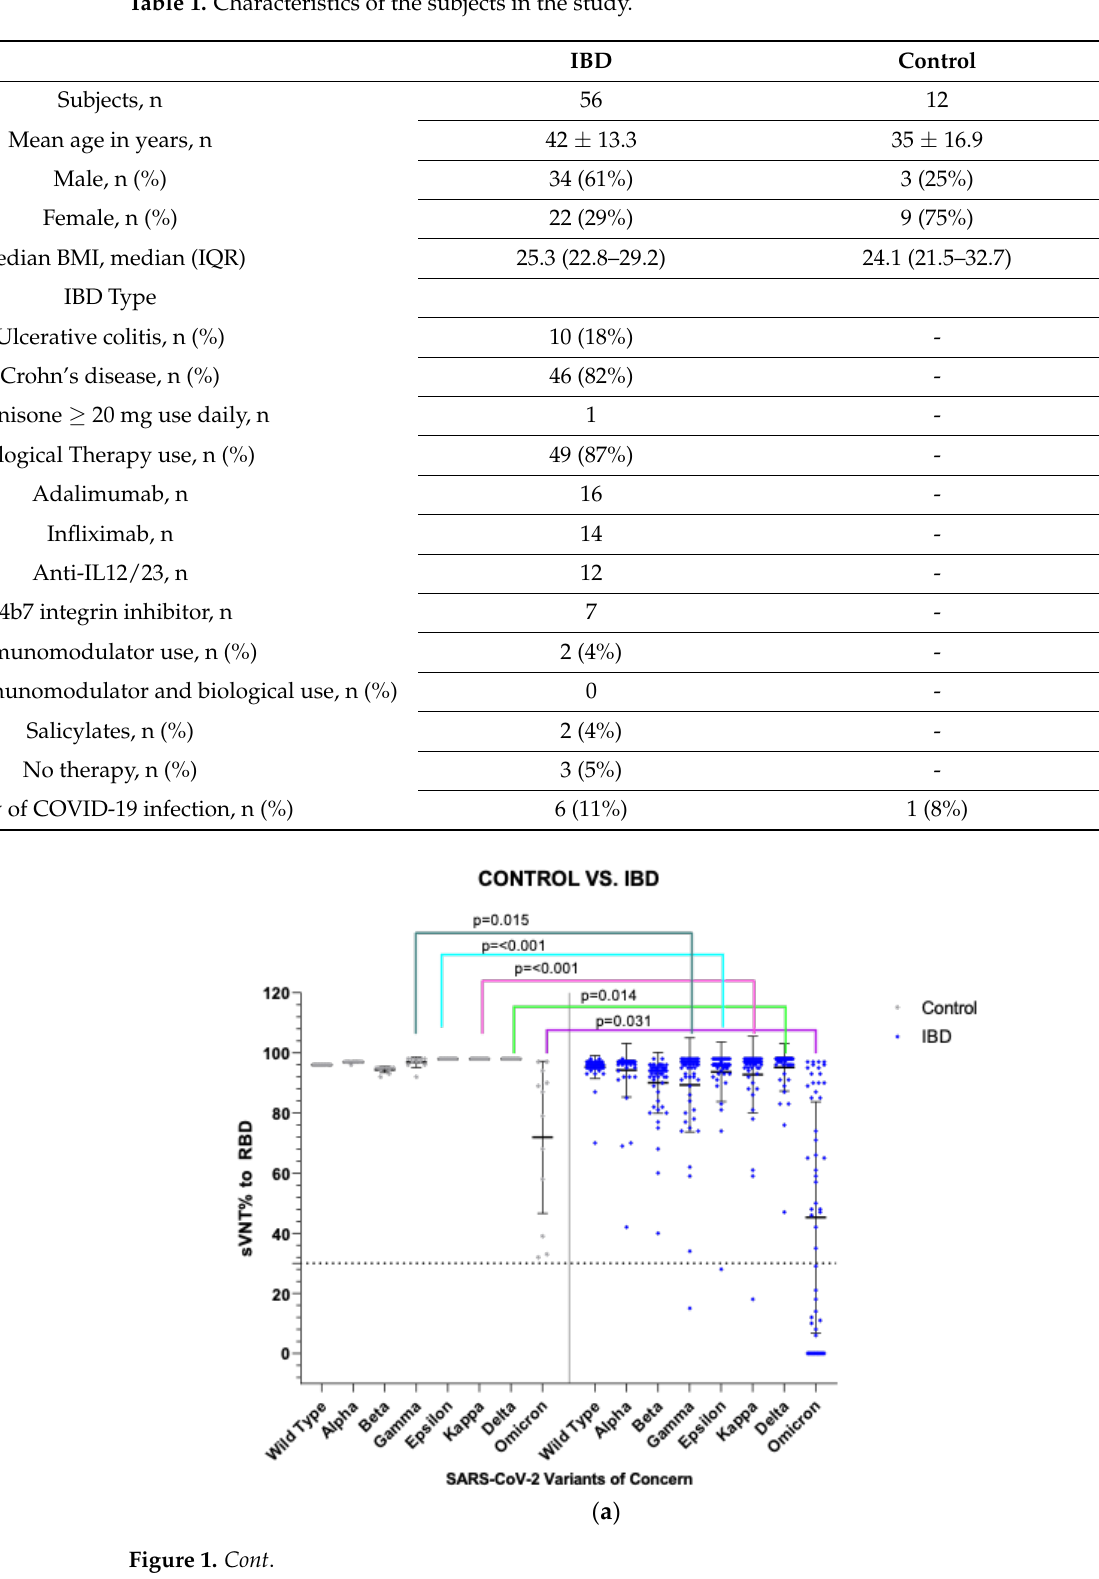
( b ) Figure 1. ( a ) Antibody neutralization against receptor binding domain (RBD) of SARS-CoV-2 vari- ants of concern in controls vs. patients with IBD after 60-days of mRNA COVID-19 vaccine. ( b ) A drug therapy mechanism stratifies antibody neutralization against SARS-CoV-2 variants of concern in patients with IBD. All the healthy controls developed detectable antibodies and effective humoral responses against all seven variants of SARS-CoV-2. Although levels against the Omicron variant were lower than those against the other variants, they developed more than 30% neutralization, which did not occur in the IBD group. The dashed line represents the limit for effective antibody neutralization (≥30%), and the bars represent the mean with standard deviation. ( b ) Twenty-four (24) subjects with IBD did not develop effective neutralizing capability against the Omicron variant.